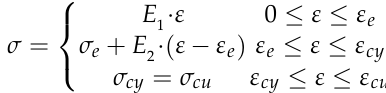
Figure 4. Stress – strain curve model of the bolt and bamboo. ( a ): Stress – strain curve model of bolt; ( b ): Stress – strain curve model of bamboo. ( b ): Stress–strain curve model of bamboo. Table 3. Engineering elastic constants of the GFRP combined with E51.